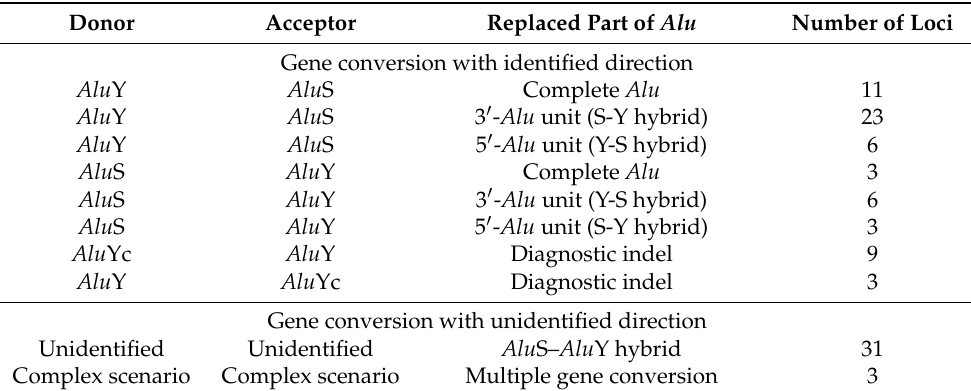
Table 1. Gene conversion cases among Alu